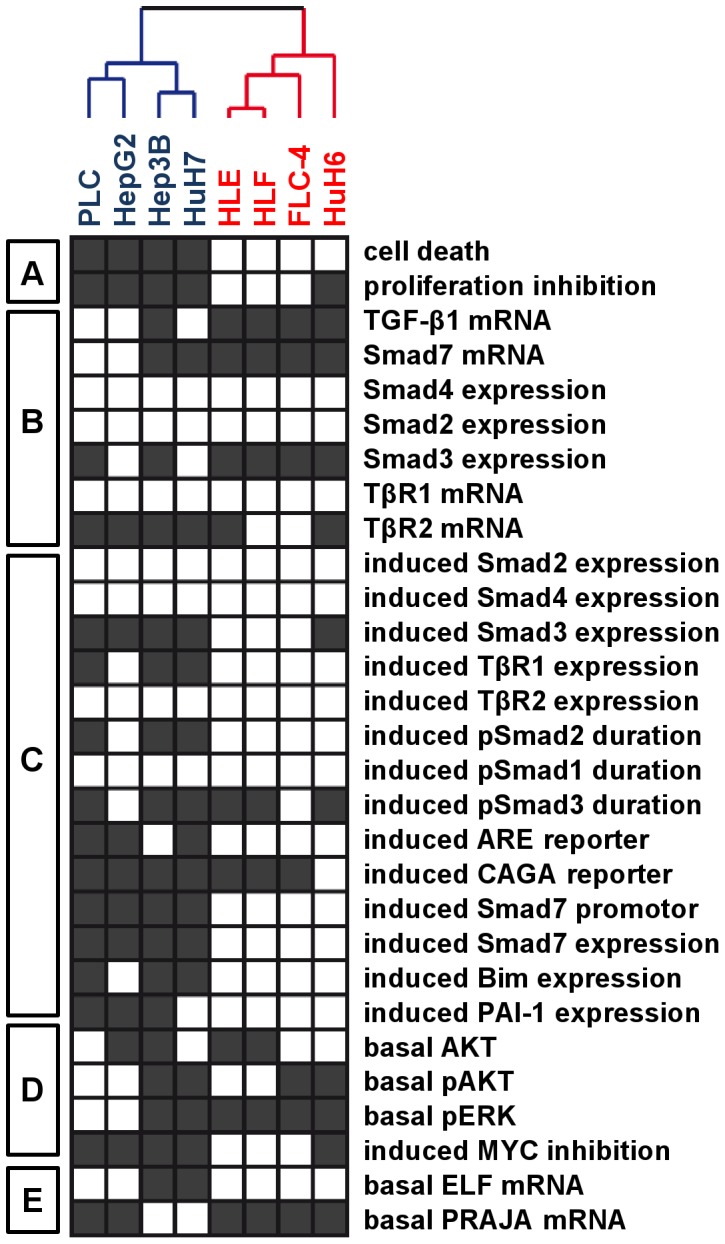
Hierarchical clustering analysis of HCC cell lines based on TGF-β/Smad signaling and cytostatic outcome.TGF-β related observations on the 10 HCC-derived cell lines (as summarized in Fig.9) were converted into an all-or-none fashion (black/white boxes) to produce a matrix which was organized by hierarchical clustering algorithm. Observations were divided into 5 broad categories (A-E, left side). (A) TGF-β dependent cytostasis (black boxes: cell death >5%; proliferation inhibition >50%), (B) basal TGF-β signaling (black boxes: 2-ΔΔCt>2.5 for all, but >4 for Smad3), (C) induced TGF-β signaling (black boxes rel. induction of expression 2-ΔΔCt> 2, induction of CAGA and Smad7 promoter and expression > 2.8, induction of ARE reporter > 5 ; prolonged duration), (D) survival signaling (black boxes: >3-fold increased for pAKT total AKT, 6-fold increased for pERK; > 40 % inhibition of c-MYC), (E) basal ELF and PRAJA expression (black boxes: 2-ΔΔCt >2 and 2-ΔΔCt >1.4 respectively). Based on the integrated above observations, clustering analysis unambiguously clustered the 10 cell lines. Beside HCC-M and HCC-T cell lines, 2 main groups were identified: group 1 included HepG2, PLC, Hep3B, HuH7 and group 2 included HLE, HLF, HuH6, FLC-4.